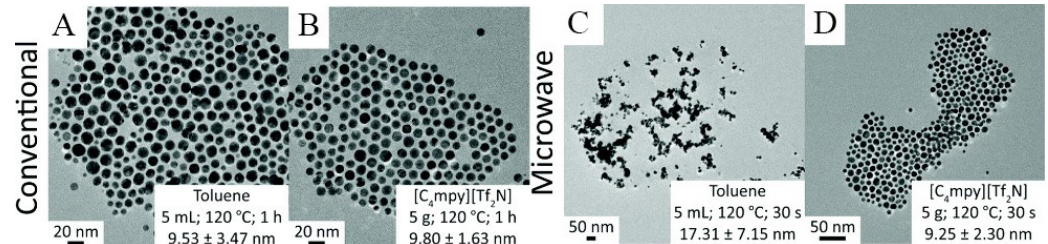
Figure 1. Scheme ( A – D ) representative transmission electron microscopy (TEM) images of Au nanoparticles (NPs) synthesized using conventional and microwave methods carried out in either toluene (panels A and C) or [C 4 mpy][Tf 2 N] (panels B and D) [43].Copyright Royal Society of Chemistry, 2018.